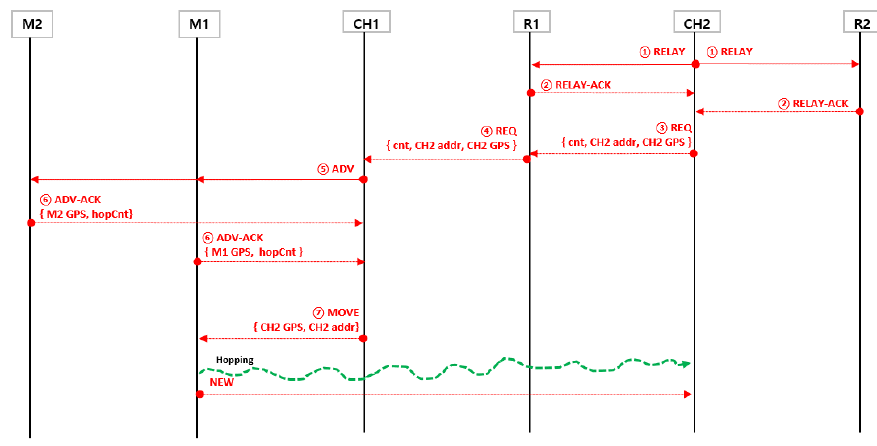
Figure 5. A message sequence diagram for the example in Figure 4.